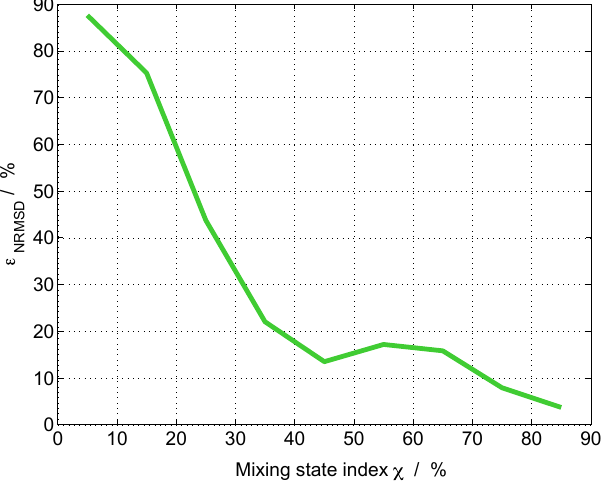
Figure 9. Normalized root mean square deviation in CCN concen- tration due to composition averaging ( (cid:15) NRMSD ) as a function of mixing state index χ ; see Eq. (3) for